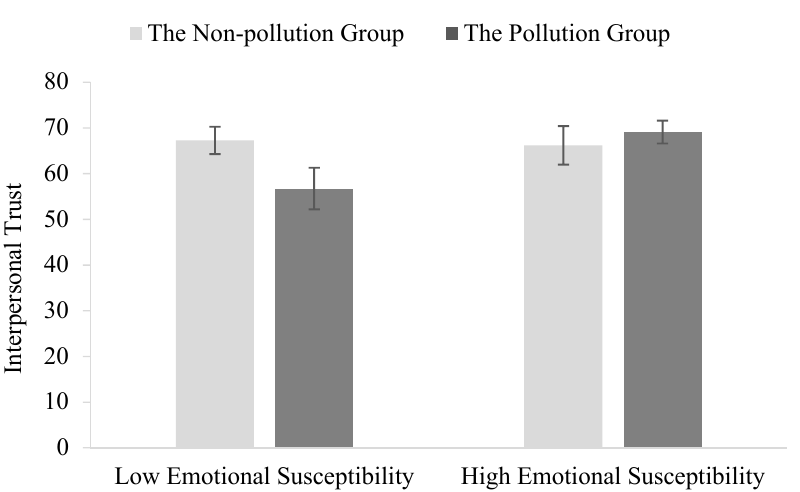
Figure 2. The interaction between air pollution and emotional susceptibility on interpersonal trust. Error bars represent 95% confidence intervals of the means. Participants who scored low on emotional susceptibility showed reduced interpersonal trust in the air pollution condition.